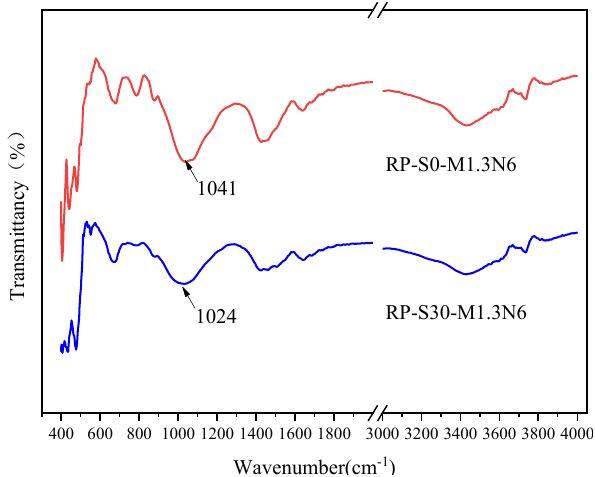
Figure 18. FTIR results of RPSG with different slag contents.